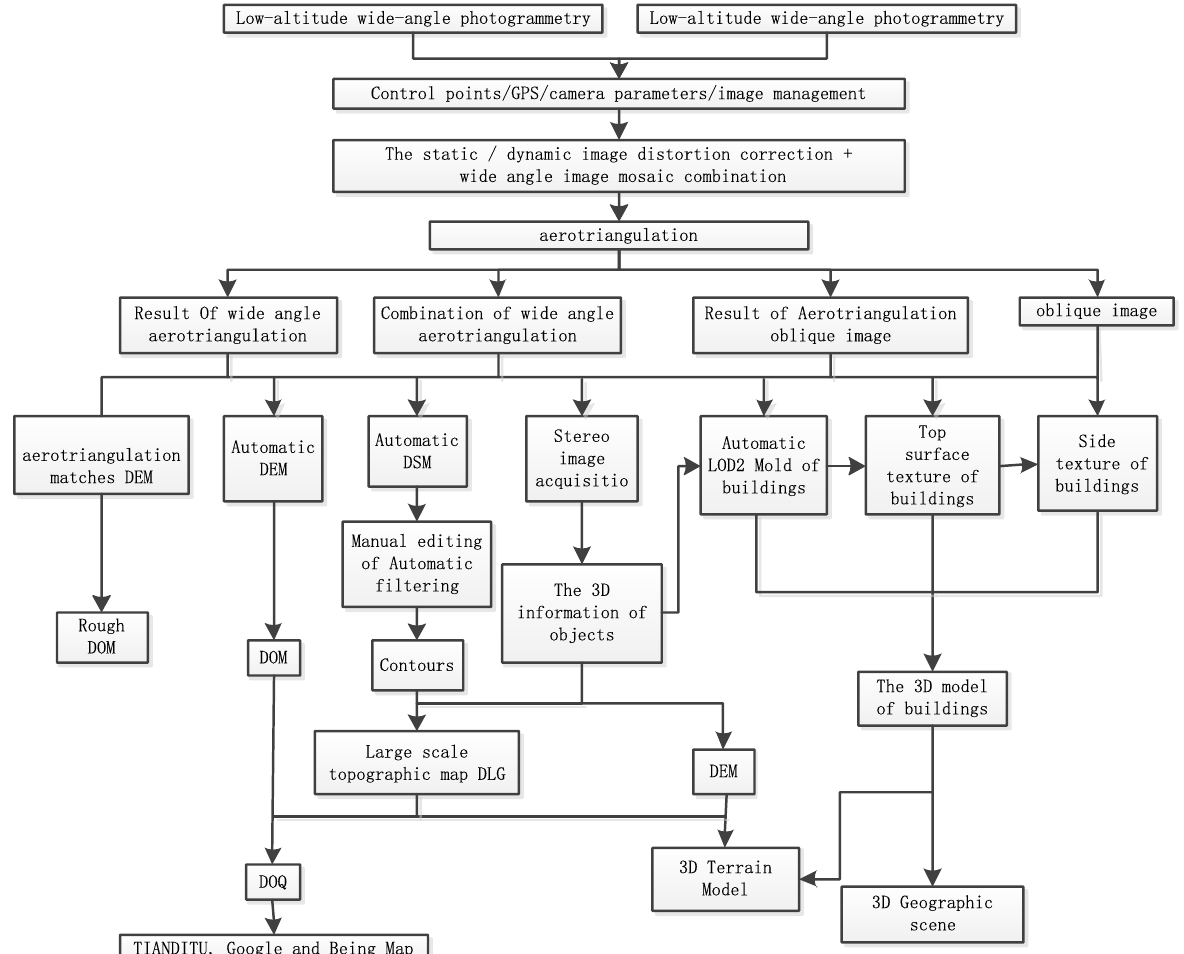
Figure 3. Production process of low altitude and large scale photogrammetry